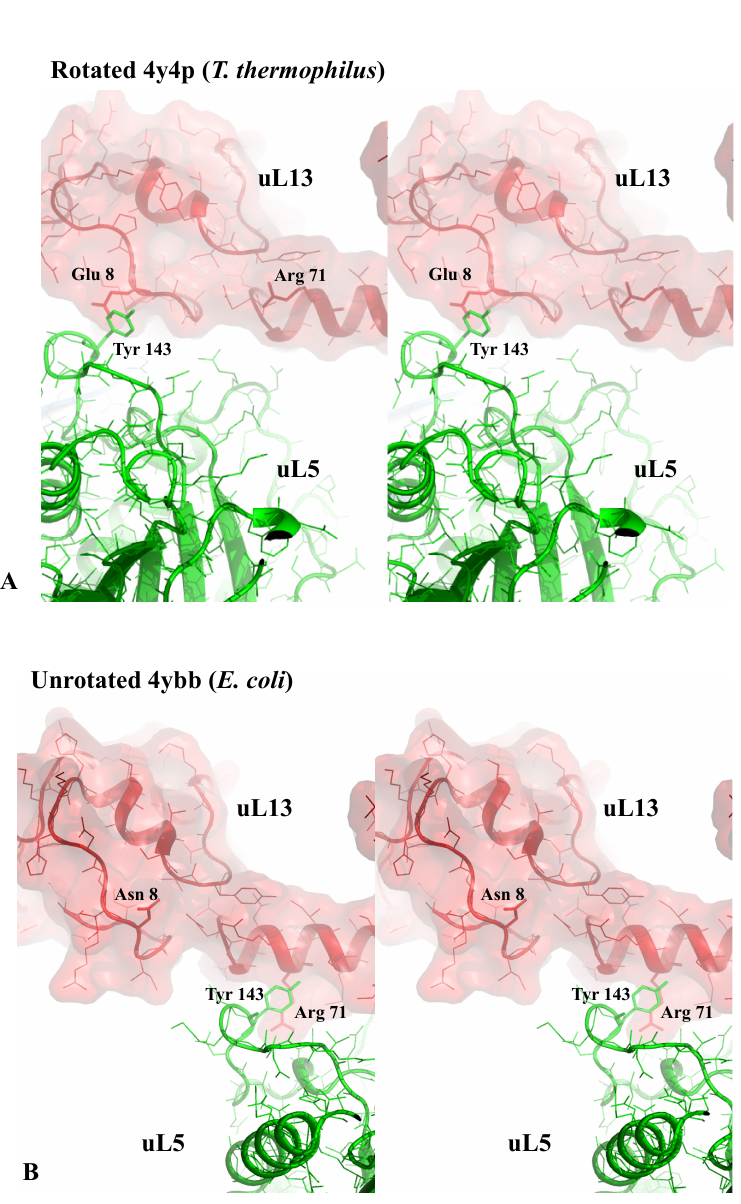
Figure 5. Sensing the rotational state of the two subunits. Stereoviews of the interaction in the inter-subunit bridge formed by uL5 and uS13. ( A ) the rotated state observed in a high-resolution structure of T. thermophilus ribosome containing the 3 tRNAs (pdb_id: 4y4p). ( B ) The un-rotated state observed in a high-resolution structure of the E. coli ribosome without bound tRNA (pdb_id: 4ybb).